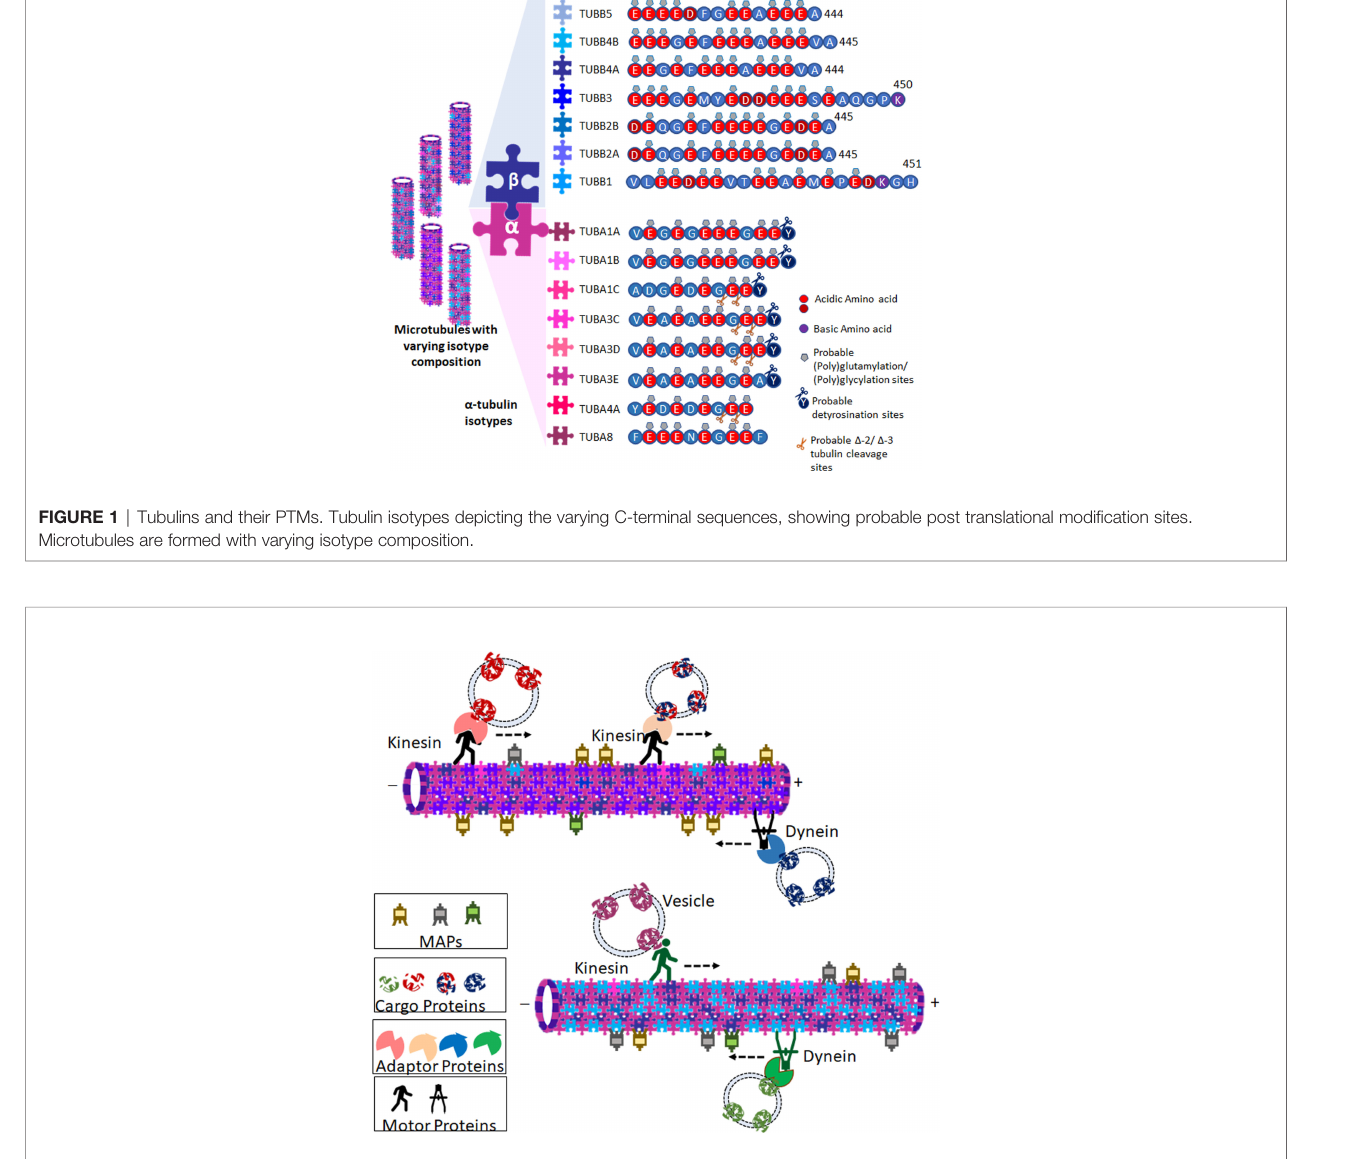
FIGURE 2 | Representation of probable theory that microtubule isotype composition contributes to speci fi city in tubulin-mediated transport. Cargos (Vesicle bound proteins or Organelles) are transported in retrograde and anterograde directions by motor proteins Dyneins and Kinesins respectively. Many of the motor proteins bind to the vesicles through adaptor proteins. Isotype composition of the microtubule in fl uences preferential binding of microtubule-associated proteins (MAPs), motor proteins, and ultimately the cargo is transported. The cartoon shows two representative microtubules with different isotype compositions. The varied relative abundance of different isotypes imparts the microtubules with diverse af fi nities towards different kinesins, dyneins, as well as MAPs. Due to the difference in isotype composition, the two microtubules carry different cargoes owing to the different motor proteins and adaptor proteins that bind to them. The association of different tubulins with different MAPs imparts varied microtubule